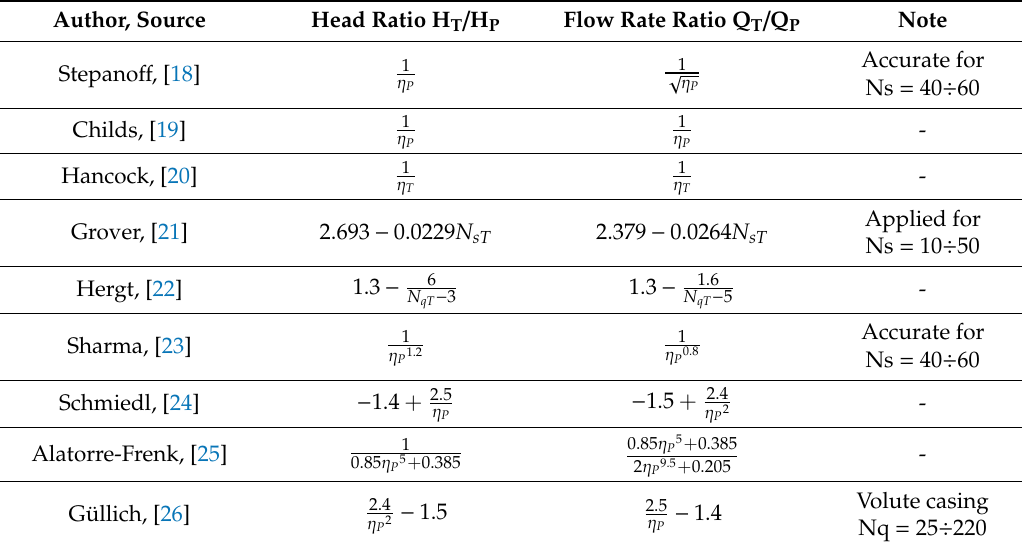
Table 1. Conversions according to various authors.